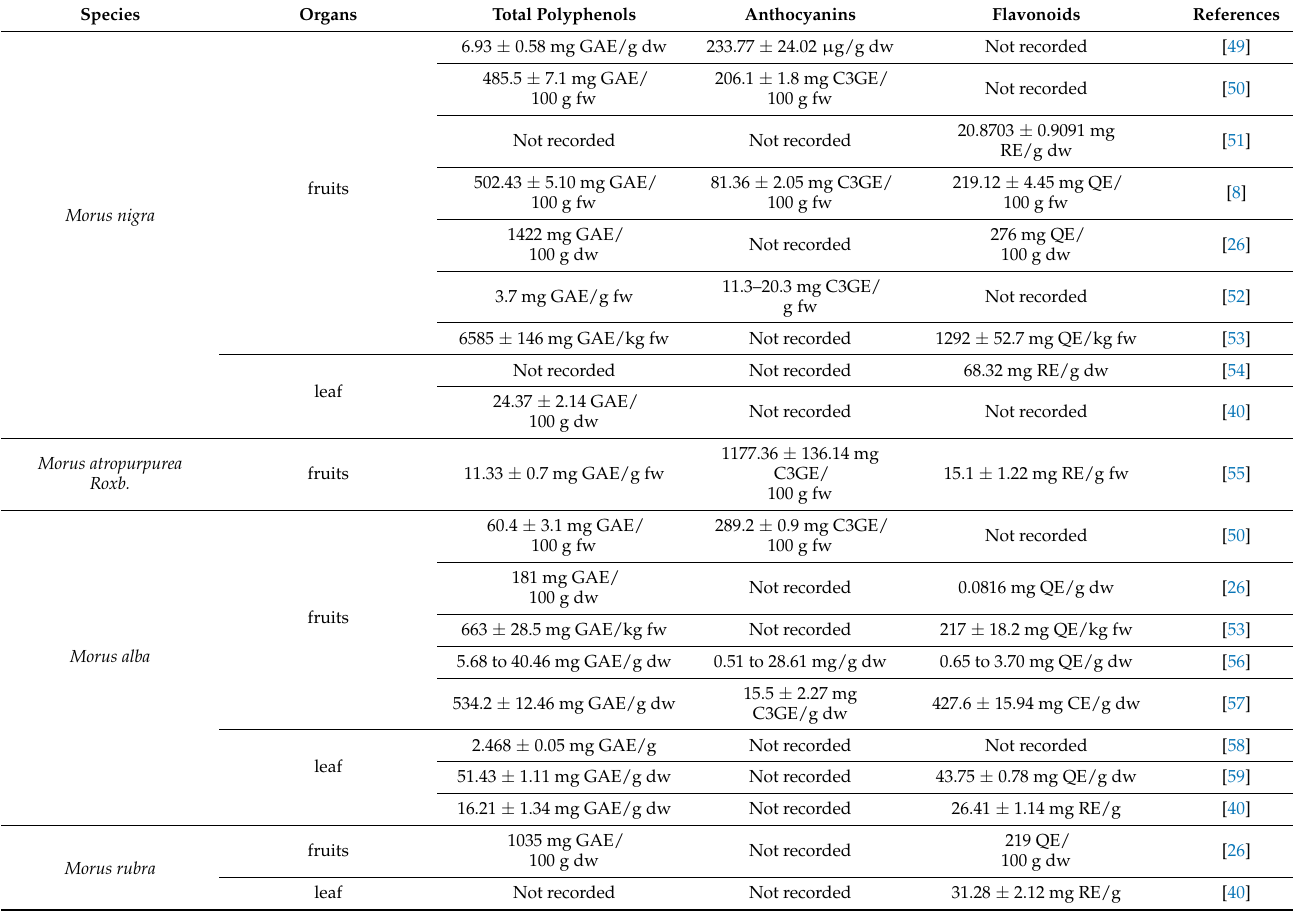
Table 1. The content of phytochemicals (polyphenols, anthocyanins and flavonoids) from mulberry fruits and leaves from data of literature of the last years